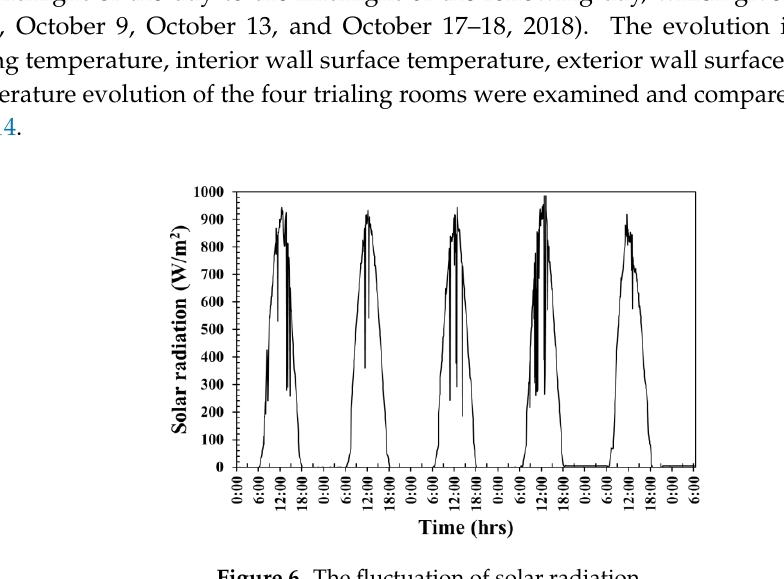
Figure 6. The fluctuation of solar radiation.